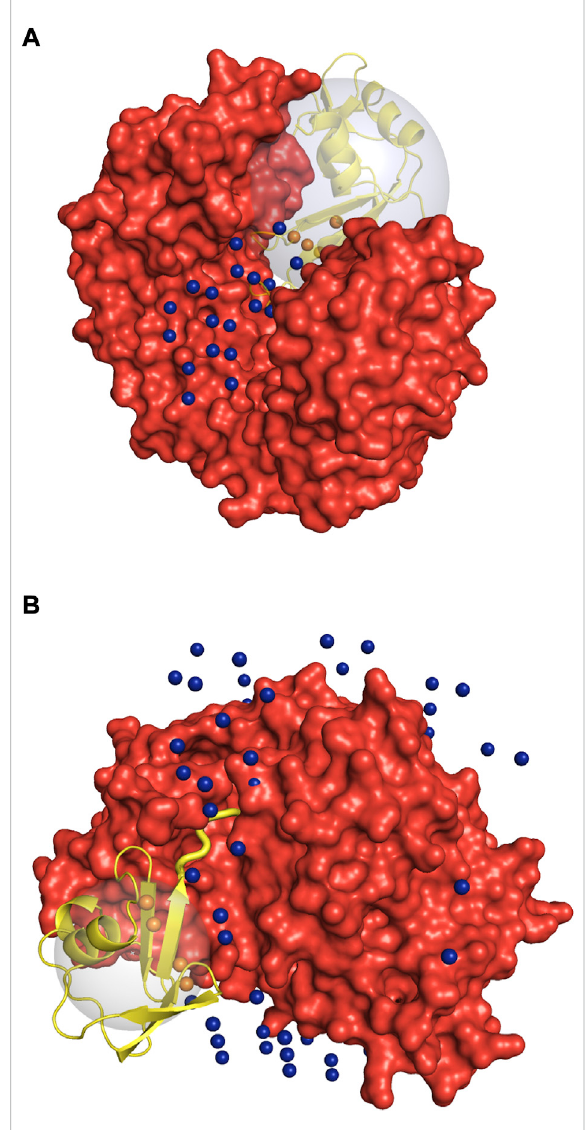
FIGURE 11 Illustration of the special cases of protein complexes. Receptor is in red, and the ligand in the native position is in yellow. The spheres are the geometric centers of the 1,000 lowest energy docked poses of the ligand inside (orange) and outside (blue) the binding site. The large gray sphere shows the space in which the ligand poses (geometric centers) are considered to be within the receptor binding site. Due to the low-resolution grid-based nature of the docking procedure used inthisstudy, one geometric center can correspond to multiple docking poses with different rotational orientation. (A) 1dfj complex: the enzymatic binding site on the receptor is too small for the crowders to fi t in. (B) 1zud complex: C-terminal of the ligand (thick yellow cartoon) binds inside a deep groove on the receptor surface. See text for